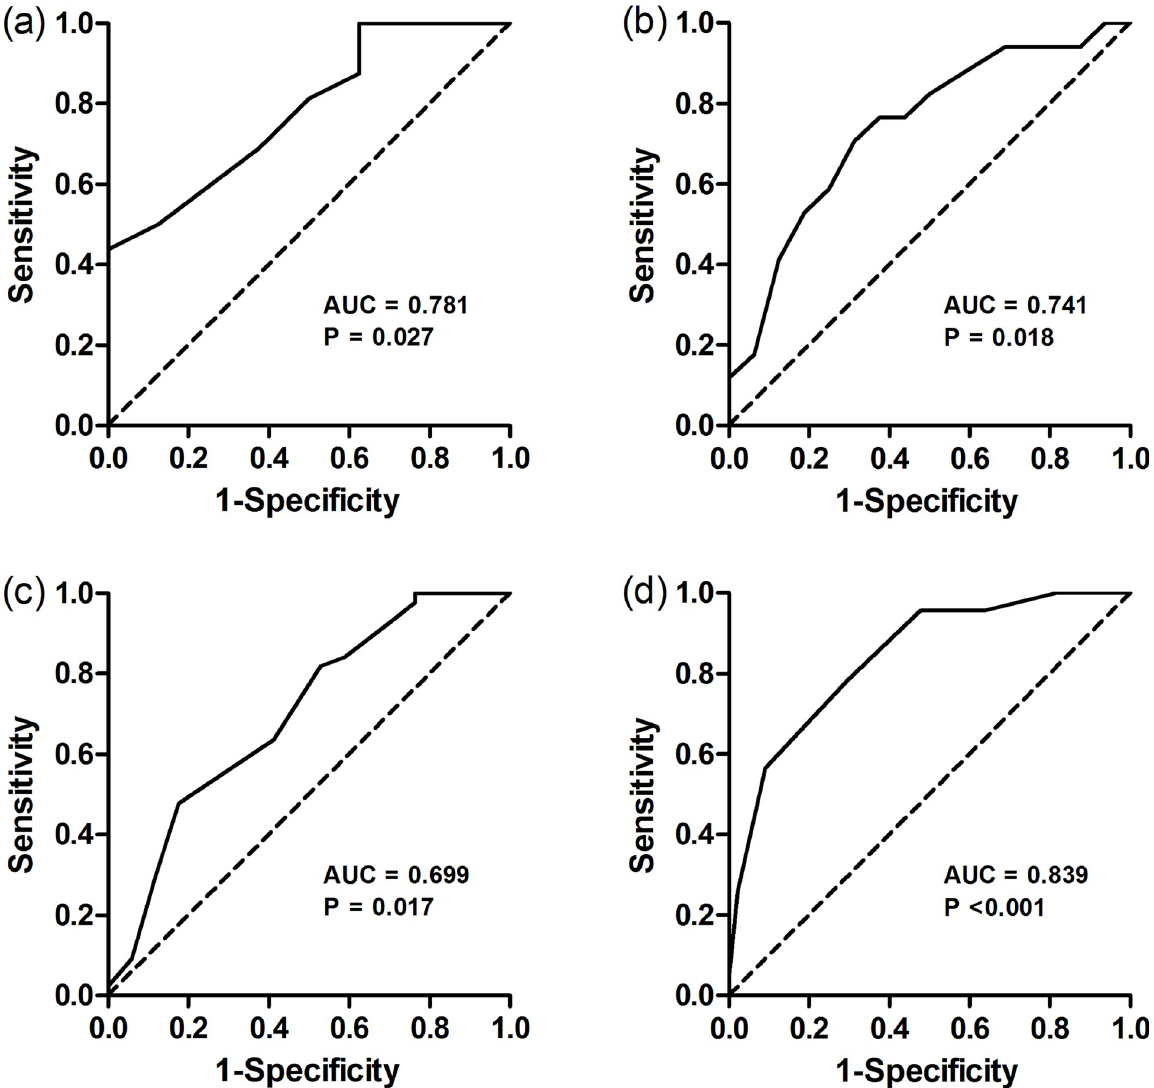
Fig 5. ROC curves indicating the power of MI to discriminate between different degrees of obstruction. (a) Severe and Moderate groups; (b) Moderate and Mild groups; (c) Mild and Early airway obstruction groups; (d) Early airway obstruction and Control groups. ROC curves (solid lines), line of identity (dashed line) and p values are given in each diagram. AUC, area under the